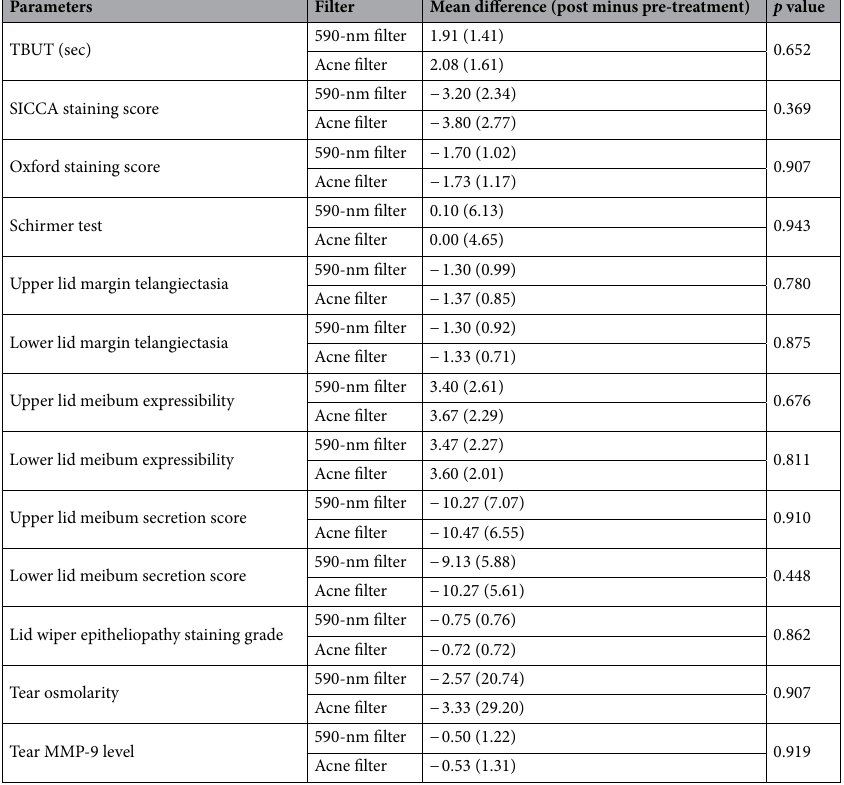
Table 3. Comparison of clinical parameters after intense pulsed light (IPL) treatment between acne and 590-nm filters. Results are presented as mean (standard deviation). TBUT, tear film break-up time;